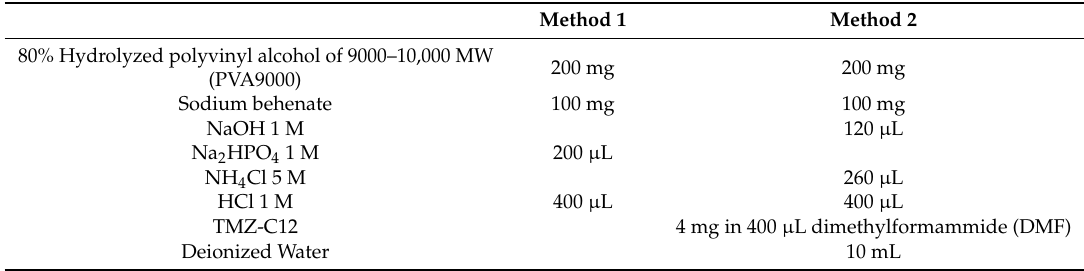
Table 1. SLN composition.